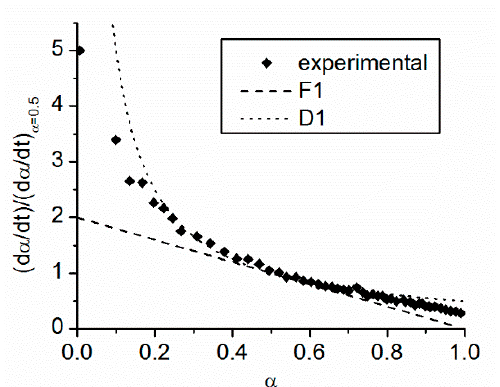
Figure 10. Experimental data compared to first order reaction model (F1) and first order diffusion model (D1) for CO production at 1000 °C by LaFe 0.7 Co 0.3 O 3 [70] .